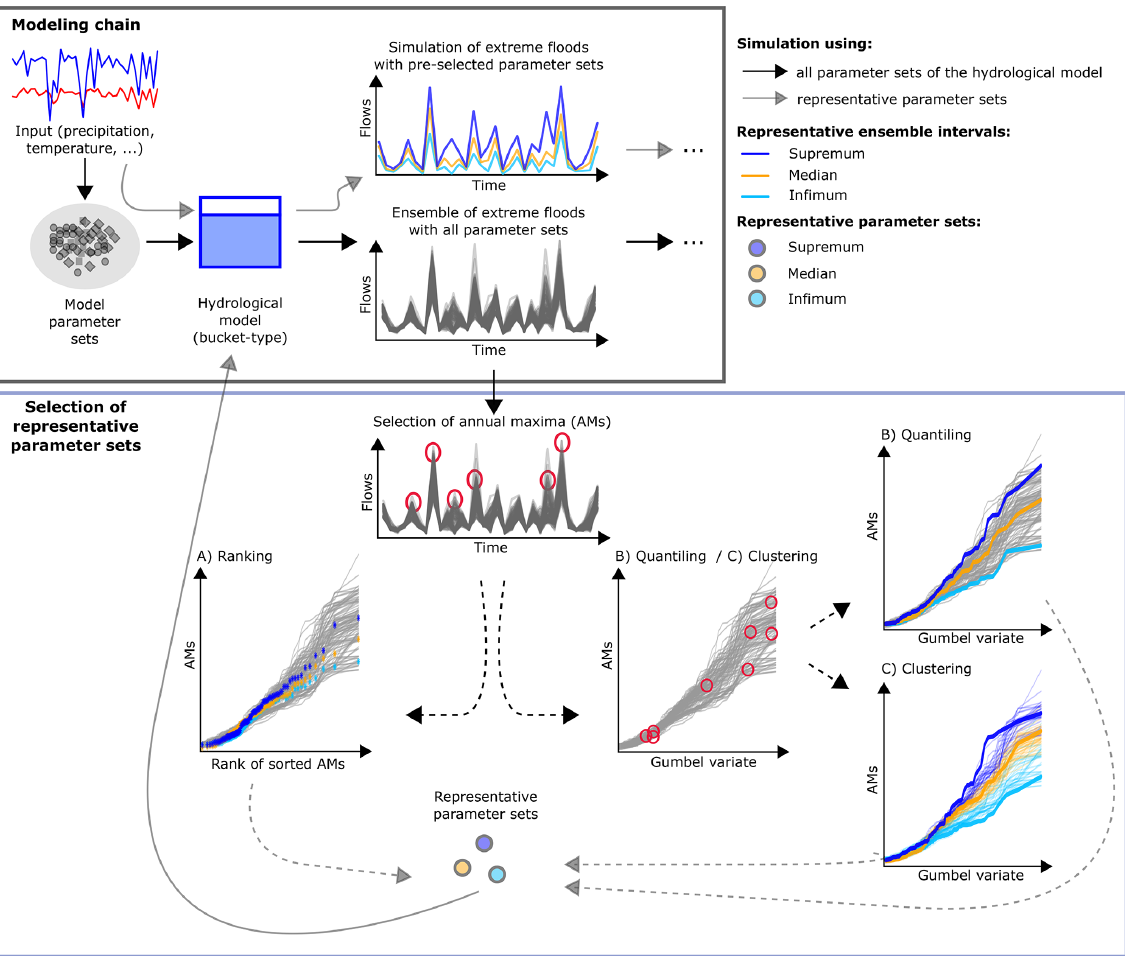
Figure 2. Overview of the modelling chain and the selection methods of the representative parameter sets; (a) delivery of hydrological- simulation ensembles and ensemble ranges; (b) three methods (A–C) proposed for selecting the representative parameter sets based on annual maxima (AMs) marked with red